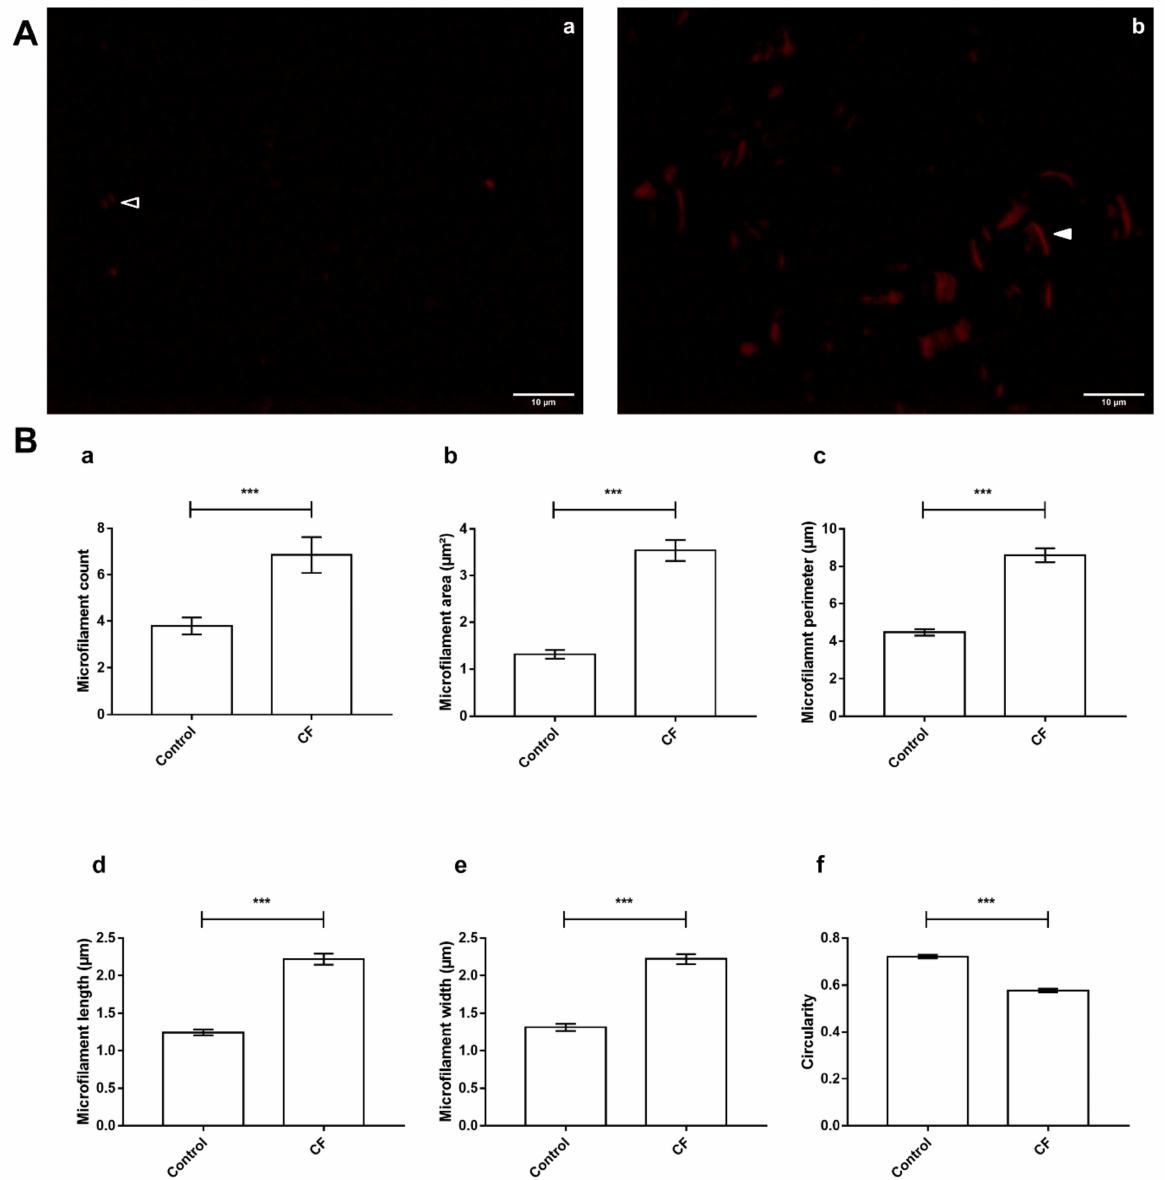
Figure 7. CF-specific abundance of sweat ABP equated to differences in the organization of F- actin microfilaments between control and CF sweat. ( A ) Specimen epifluorescence micrographs of free-in-solution Phalloidin-TRITC-labeled F-actin microfilaments in control ( a ) and CF ( b ) sweat. Arrowheads: control (empty) and CF (plain) microfilament specimens, scale bar = 10 µ m. ( B ) Mean count ( a ), area and perimeter ( b , c ), length ( d ), width ( e ), and circularity ( f ) of thresholded particles assimilated to F-Actin microfilaments, between control and CF sweat. Mean ± S.E.M. Student’s t -test for statistical significance analysis: *** p < 0.001, ( n = 5, 5 controls compared to 5 patients with CF; n micrographs = 20 per